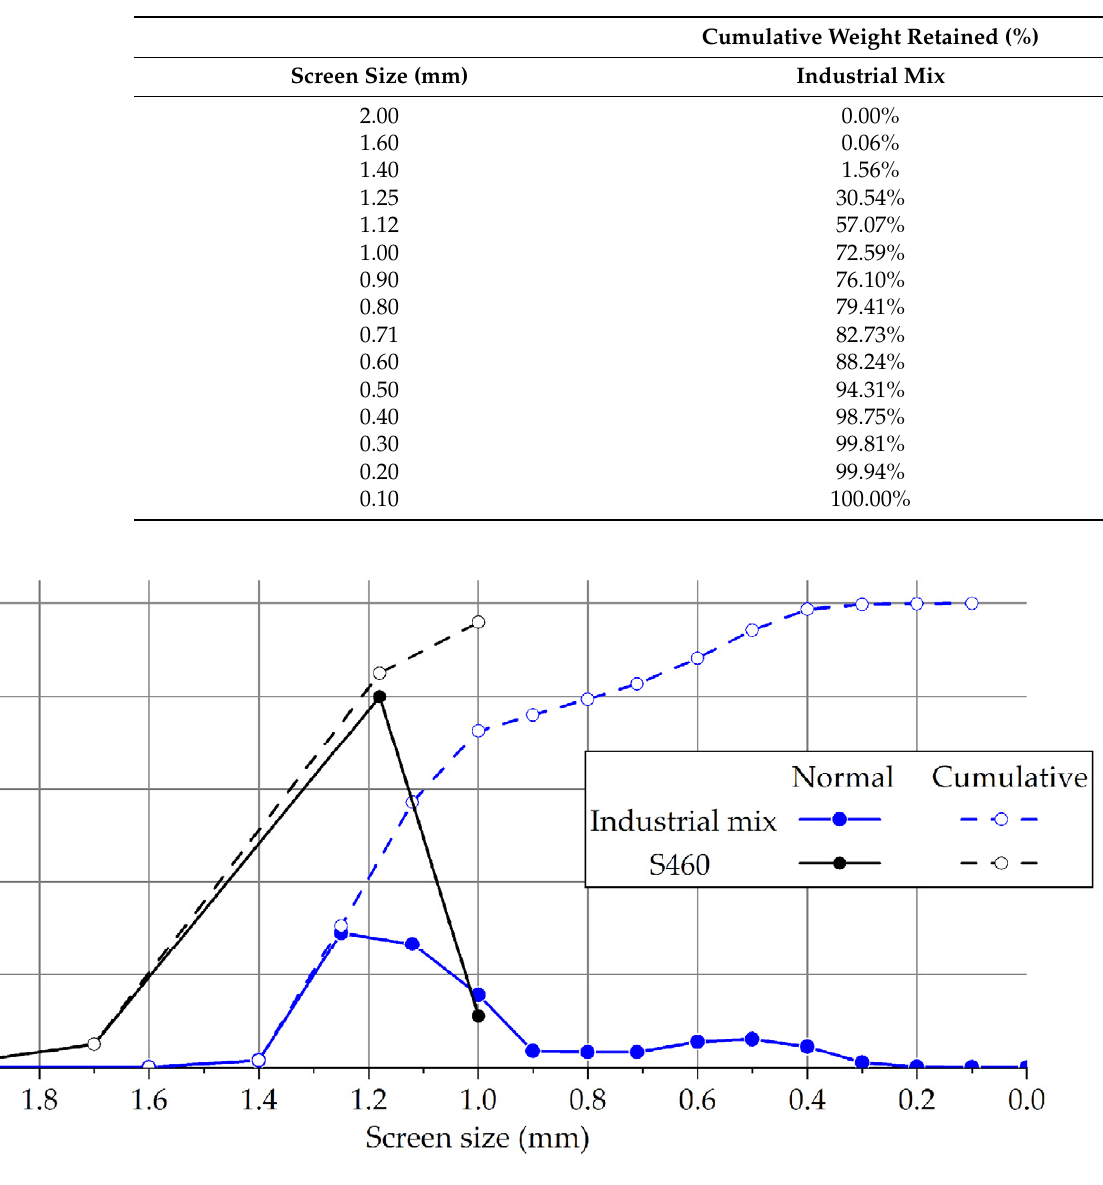
Table 3. Sieve analysis data of brand-new shots according to SAE J444 (cumulative percentage mass for each sieve level).